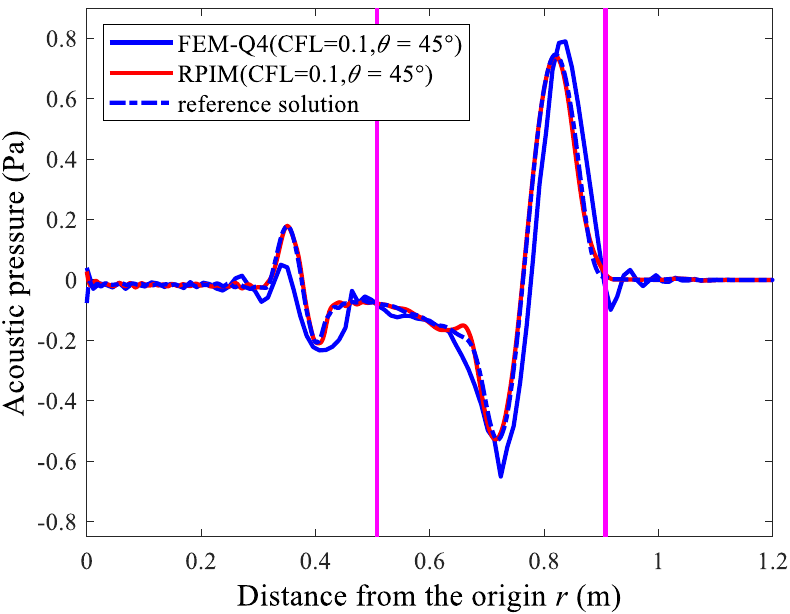
Figure 15. The transient responses of the acoustic pressure distributions from different methods for the two-dimensional scattering problem when the time point t = 0.7 s.